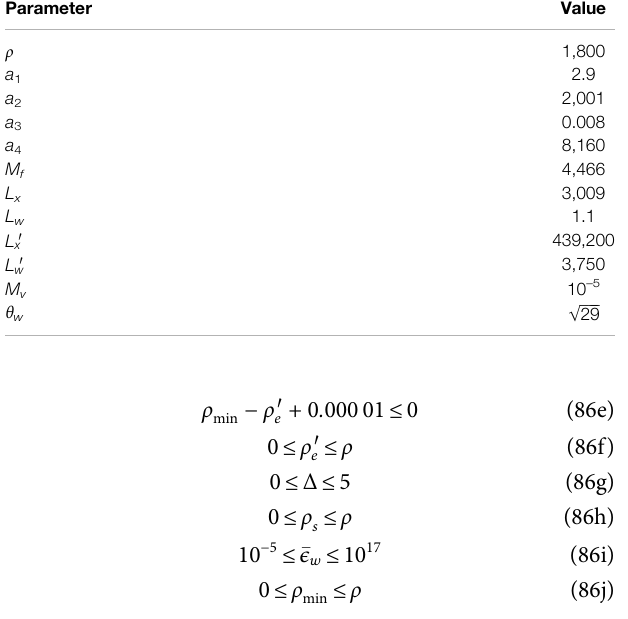
TABLE 3 | First set of parameters for CSTR